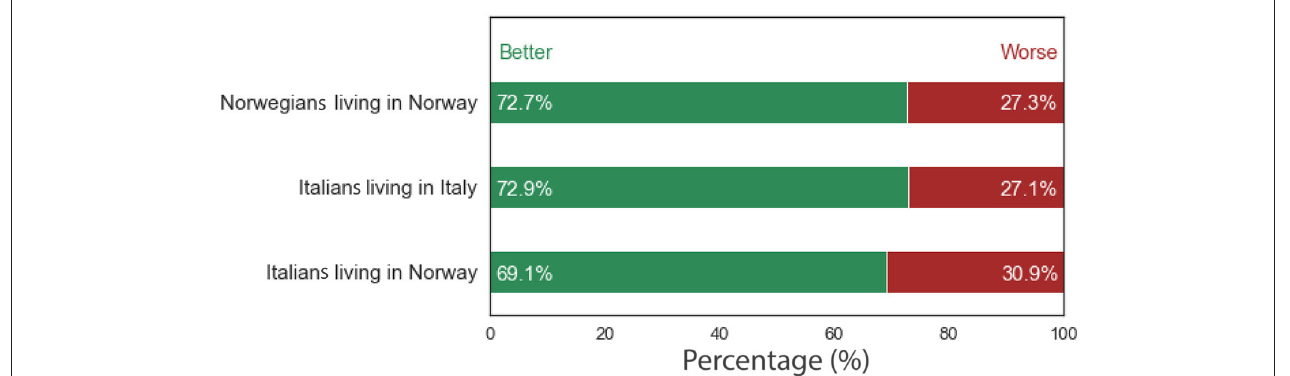
FIGURE 1 | Self-rated health among Norwegians, Italians, and Italian immigrants living in Norway.